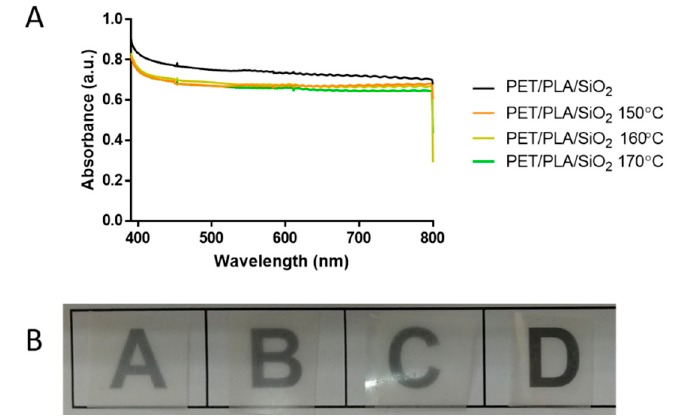
Figure 8. ( A ) Ultraviolet-visible (UV-Vis) transparency measurements of the polyethylene terephthalate (PET)/polylactide (PLA)/silica (SiO 2 ) films at different annealing temperatures. ( B ) Contact transparency of the PET/PLA/SiO 2 films: A—Without annealing; B—Annealed at 150 °C; C—Annealed at 160 °C; D—Annealed at 170 °C. The typical sample size of the films in the pictures is of ca. 2 × 1.5 cm 2 .